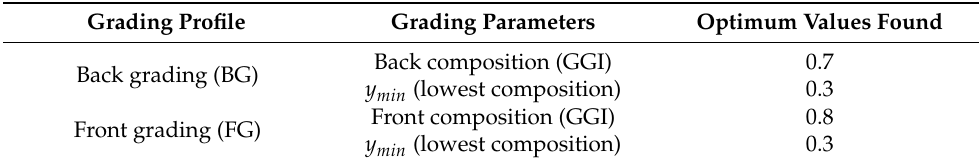
Table 6. Optimum Values of Grading Parameters Related to BG and FG Determined from